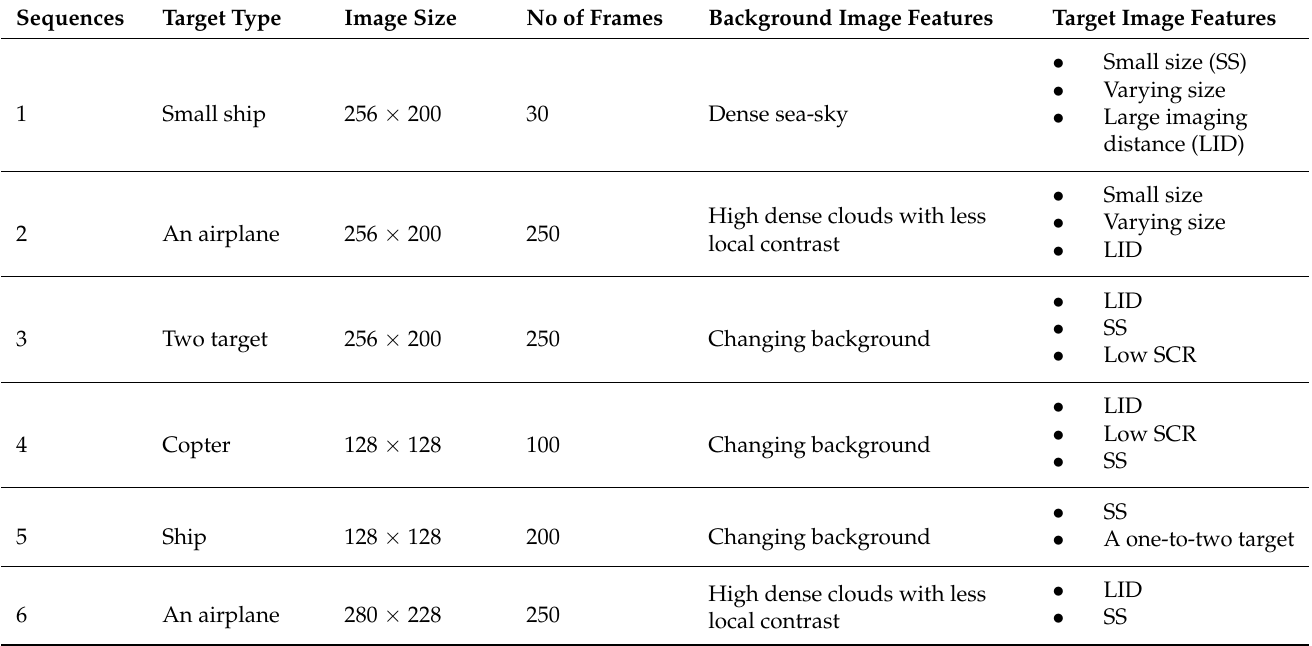
Table 2. Summary of the real image sequence data.